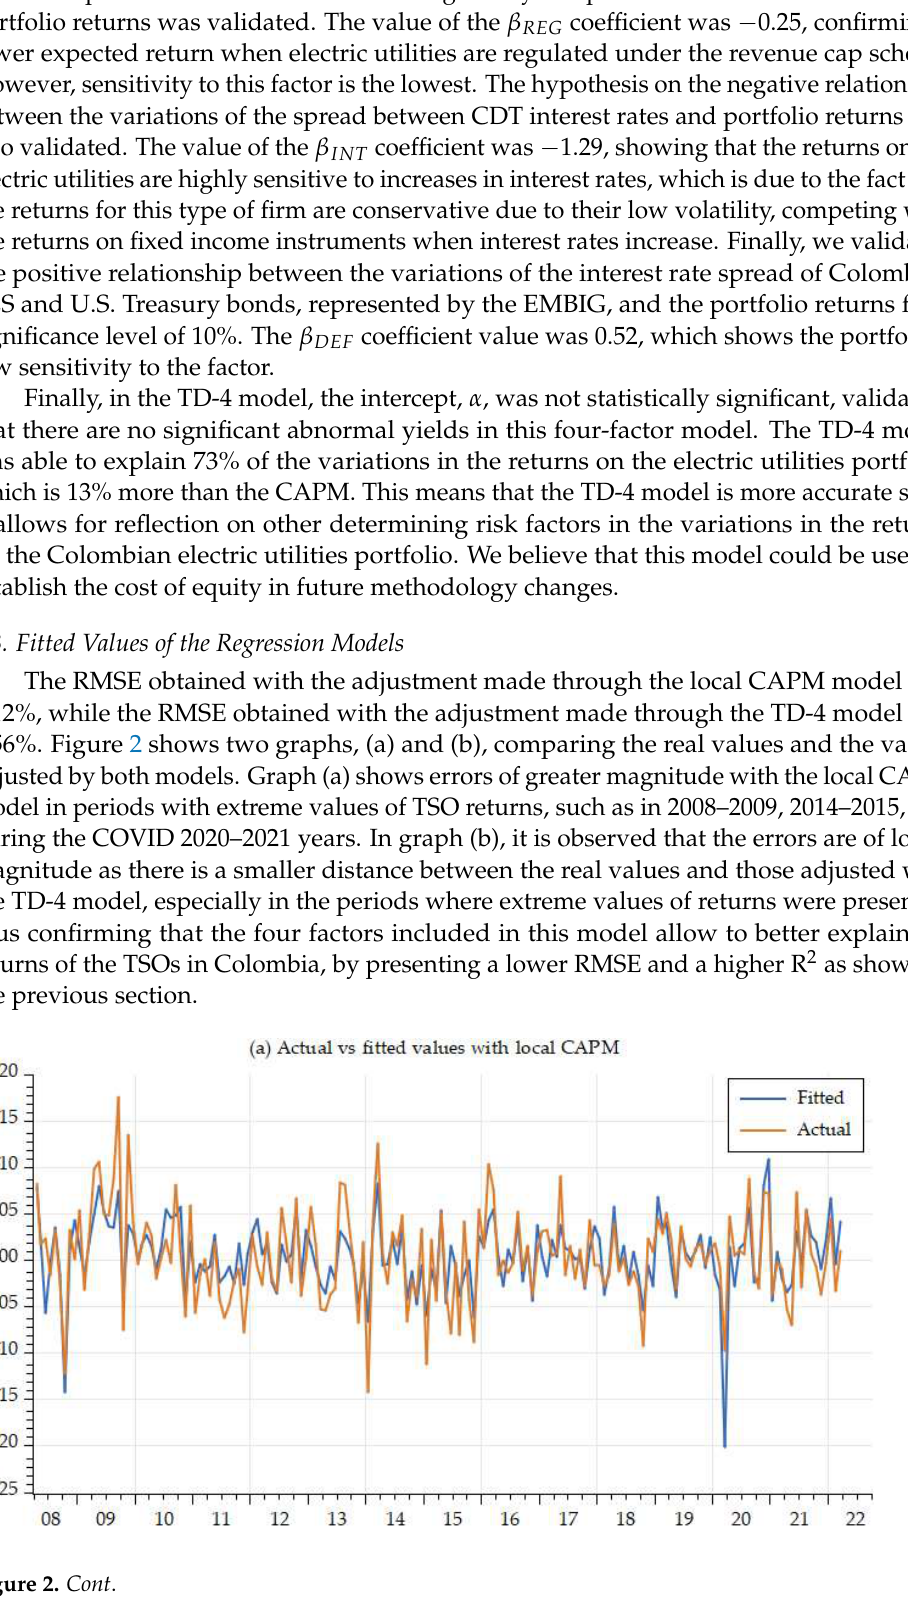
Figure 2. Actual vs. fitted values with the local CAPM and TD-4 models. 5.4. WACC Table 6 shows all the variables used in calculating the real pre-tax WACC. The first column shows the different components of the WACC calculation. The second column shows all the variables used, and the third column shows the values of the variables es- tablished by CREG to calculate the WACC with the cost of equity estimated using the CAPM with the beta method compared with the U.S. market. Finally, the fourth and fifth columns show the WACC calculation using the local CAPM and local TD-4 models eval- uated in this study. As mentioned in Section 4, only the cost of equity capital was changed in the WACC calculation. The other values remained constant, as defined in the CREG document. At the bottom of Table 6, we can see that when using the local CAPM, the Pre-Tax Real WACC was 5.89%, approximately half of the present value. When using the TD-4